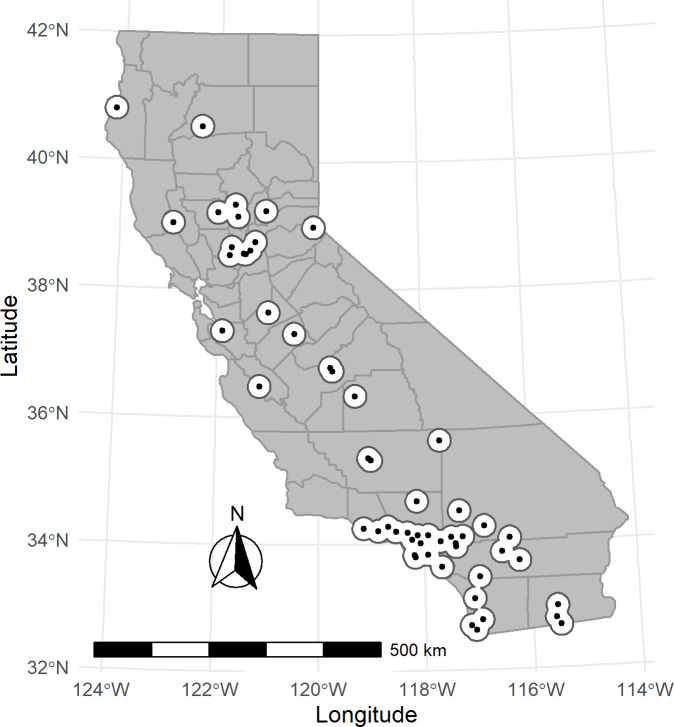
Map of study PM2.5 air monitors (with 20-kilometer buffer) in California (N = 51).